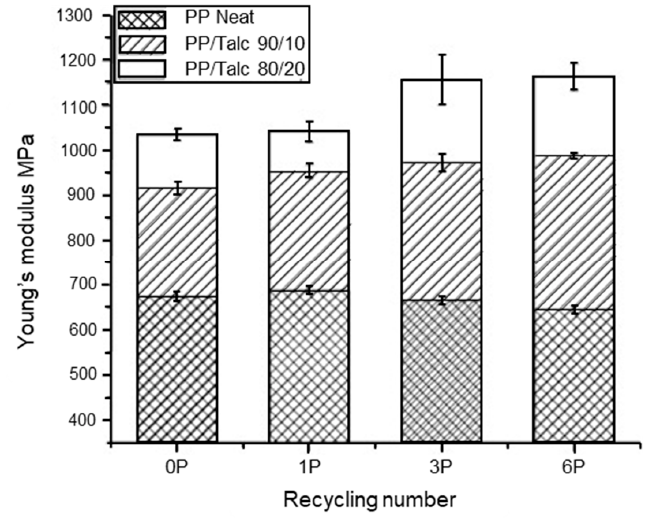
Figure 9. Young’s modulus of non-recycled and recycled neat PP and PP/talc composites. Repro- duced with permission [213].